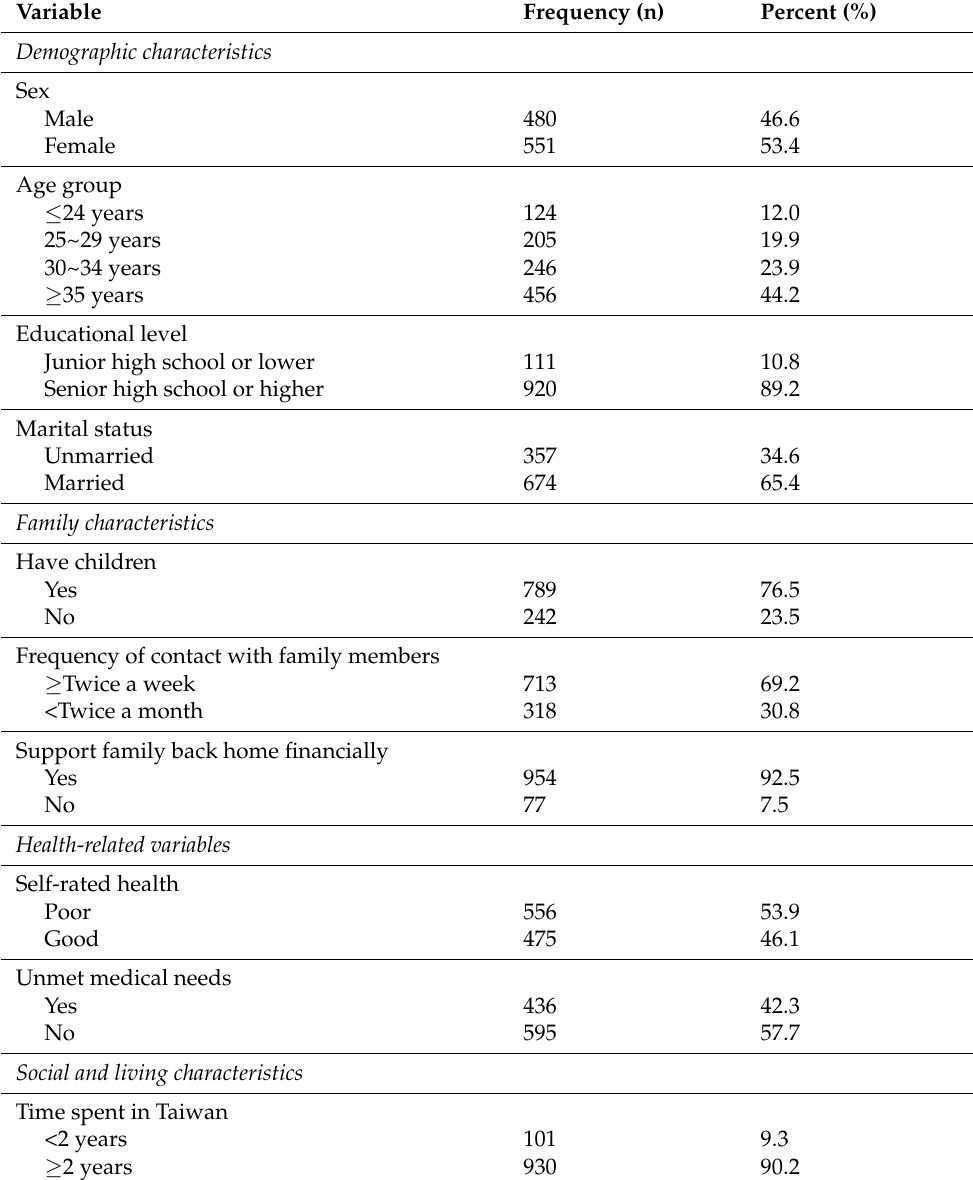
Table 1. Frequency distribution of characteristics among Indonesian migrant workers (n =